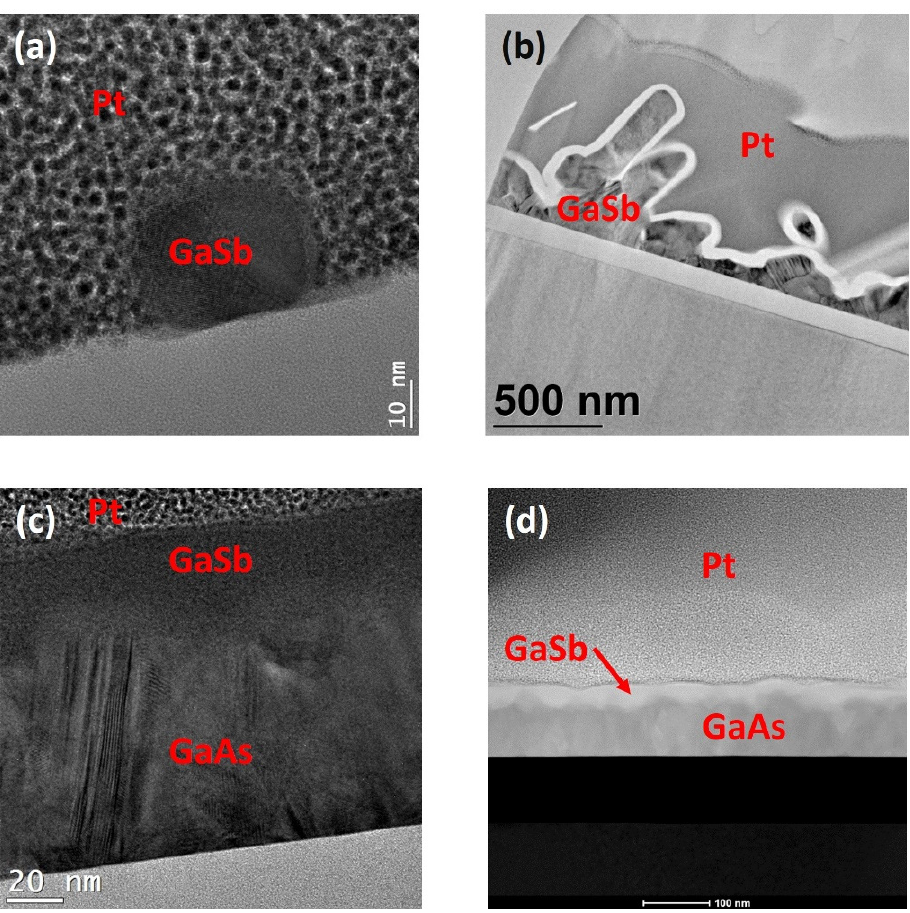
Figure 2. XTEM images of ( a ) 50 nm GaSb on SiO 2 , ( b ) 250 nm GaSb on SiO 2 , and ( c ) 50 nm GaAs + 50 nm GaSb on SiO 2 . ( d ) STEM of 50 nm GaAs + 50 nm GaSb on SiO 2 .